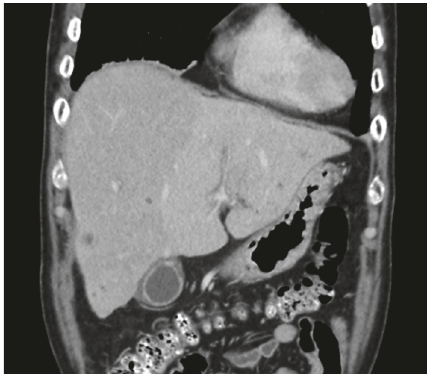
Figure 3: Coronal computed tomography (CT) scan (portal venous phase) shows gallbladder wall congestion and the periportal halo is visualized in the left lobe of the